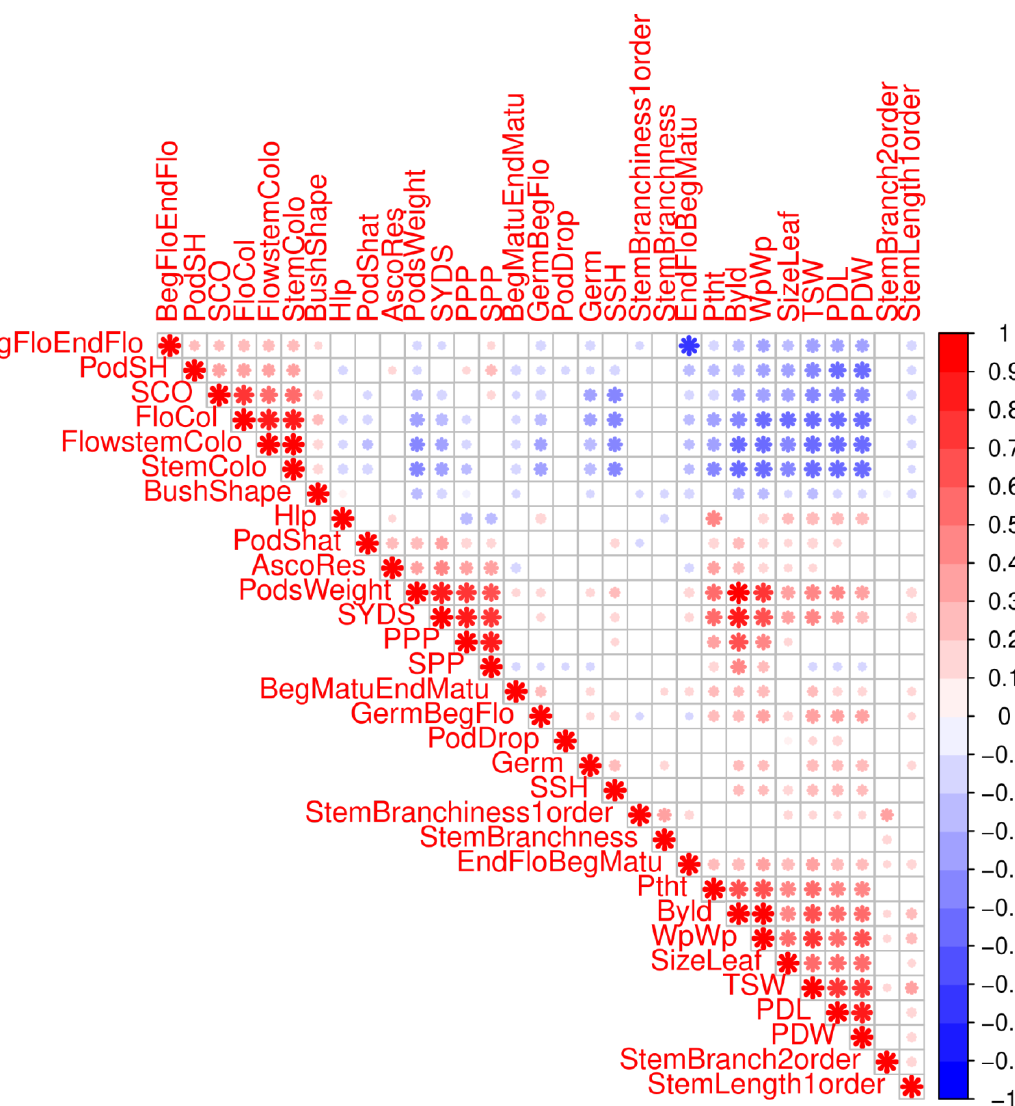
Figure 2. Correlation of thirty-one phenotypic traits. The scored phenotypes and their abbreviations are presented in Table S4. Ascochyta , the degree of damage (AsoDes) trait, was excluded from correlation analysis because it is the opposite value of Ascochyta resistance (AscoRes) trait. Moreover, we excluded overlapping time periods traits. Color intensity and the size of the asterisk are proportional to the correlation coefficients. PodSH, pod shape; SCO, seed color; SSP, number of seeds per plant; SSH, seed shape; TSW, thousand seeds weight; PDW, pod width; PDL, pod length.